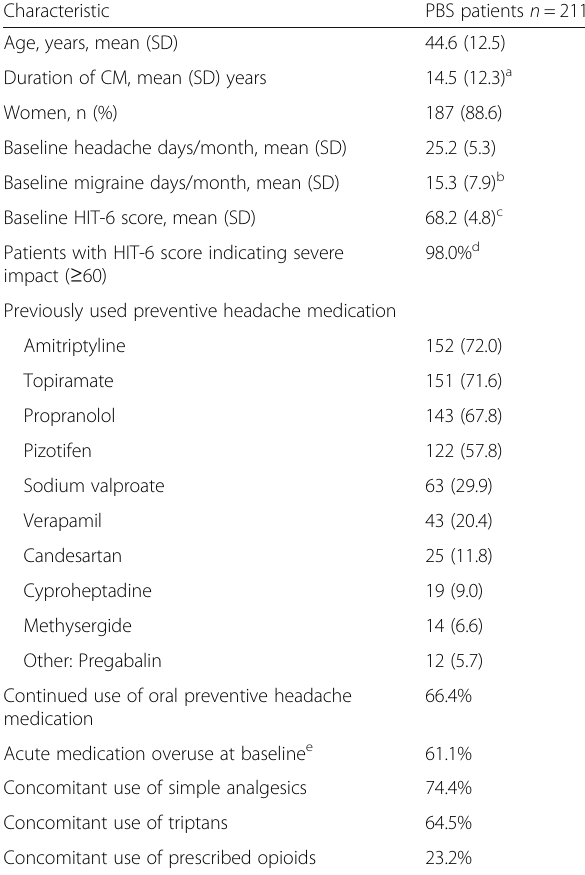
Table 1 Baseline demographics, clinical characteristics, and treatments of PBS